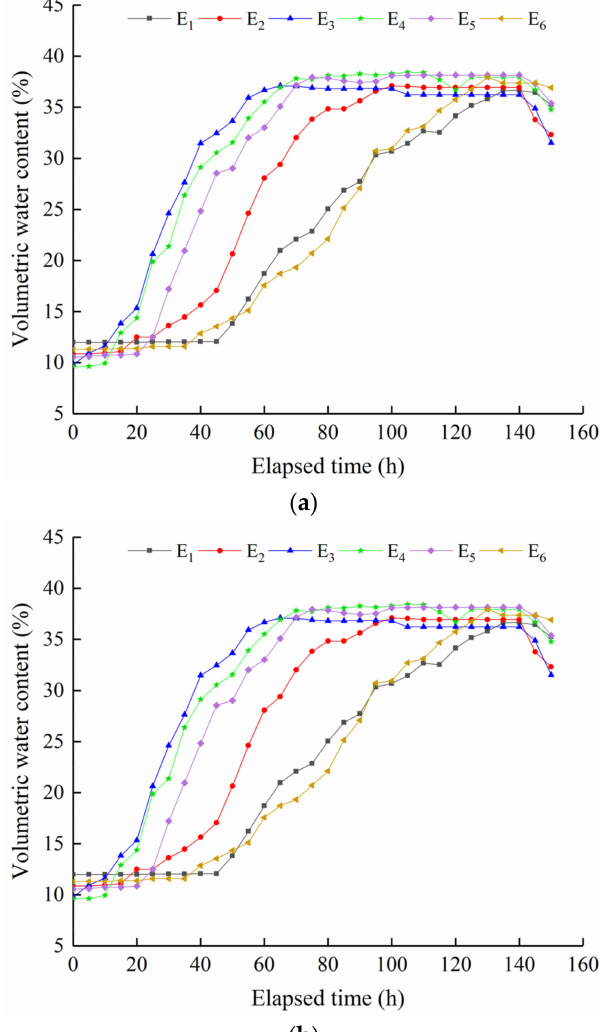
Figure 8. Change curves of volumetric water content at measuring points: ( a ) under heavy rainfall; ( b ) under